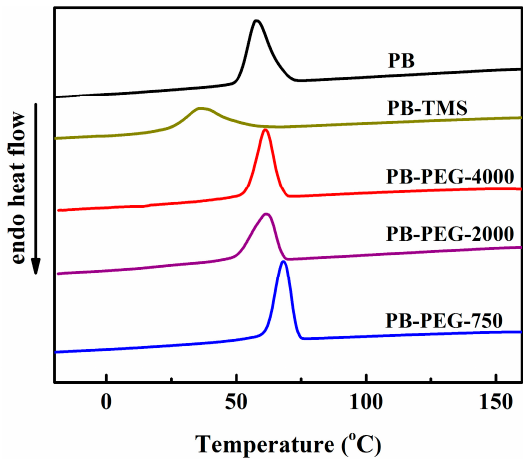
Figure 1. Differential scanning calorimetry (DSC) cooling curves of the homopolymer polybutene-1 (PB), copolymer PB-TMS, and polyethylene glycol (PEG)-grafted butene-1 copolymers. Table 2. Crystallization temperature ( T c ) and crystallinity ( X c ) of the PB, PB-TMS, and PB-PEG copolymers. Sample Code